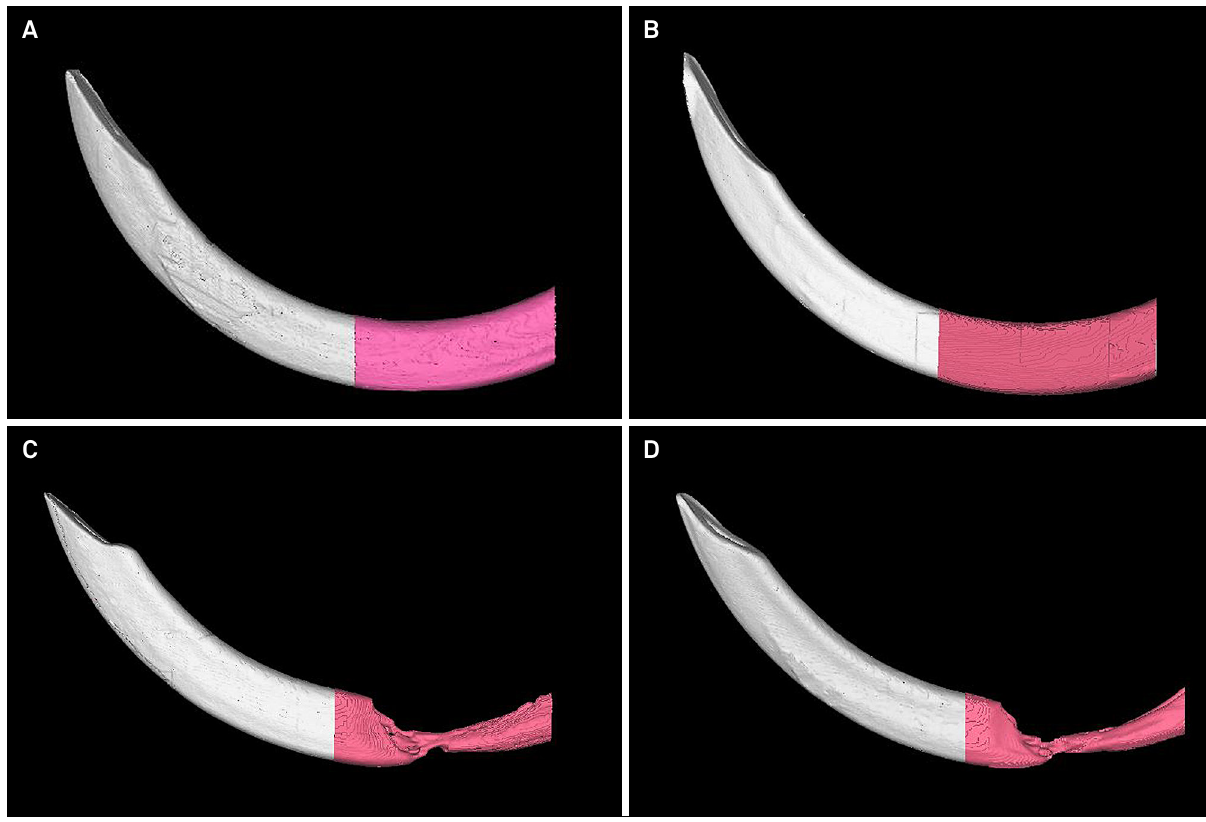
Figure 2. Three-dimensional reconstructions showing the differences in incisor volume among the groups: A- Control group, B- Resveratrol group, C- Irradiated control group, and D- Irradiated resveratrol